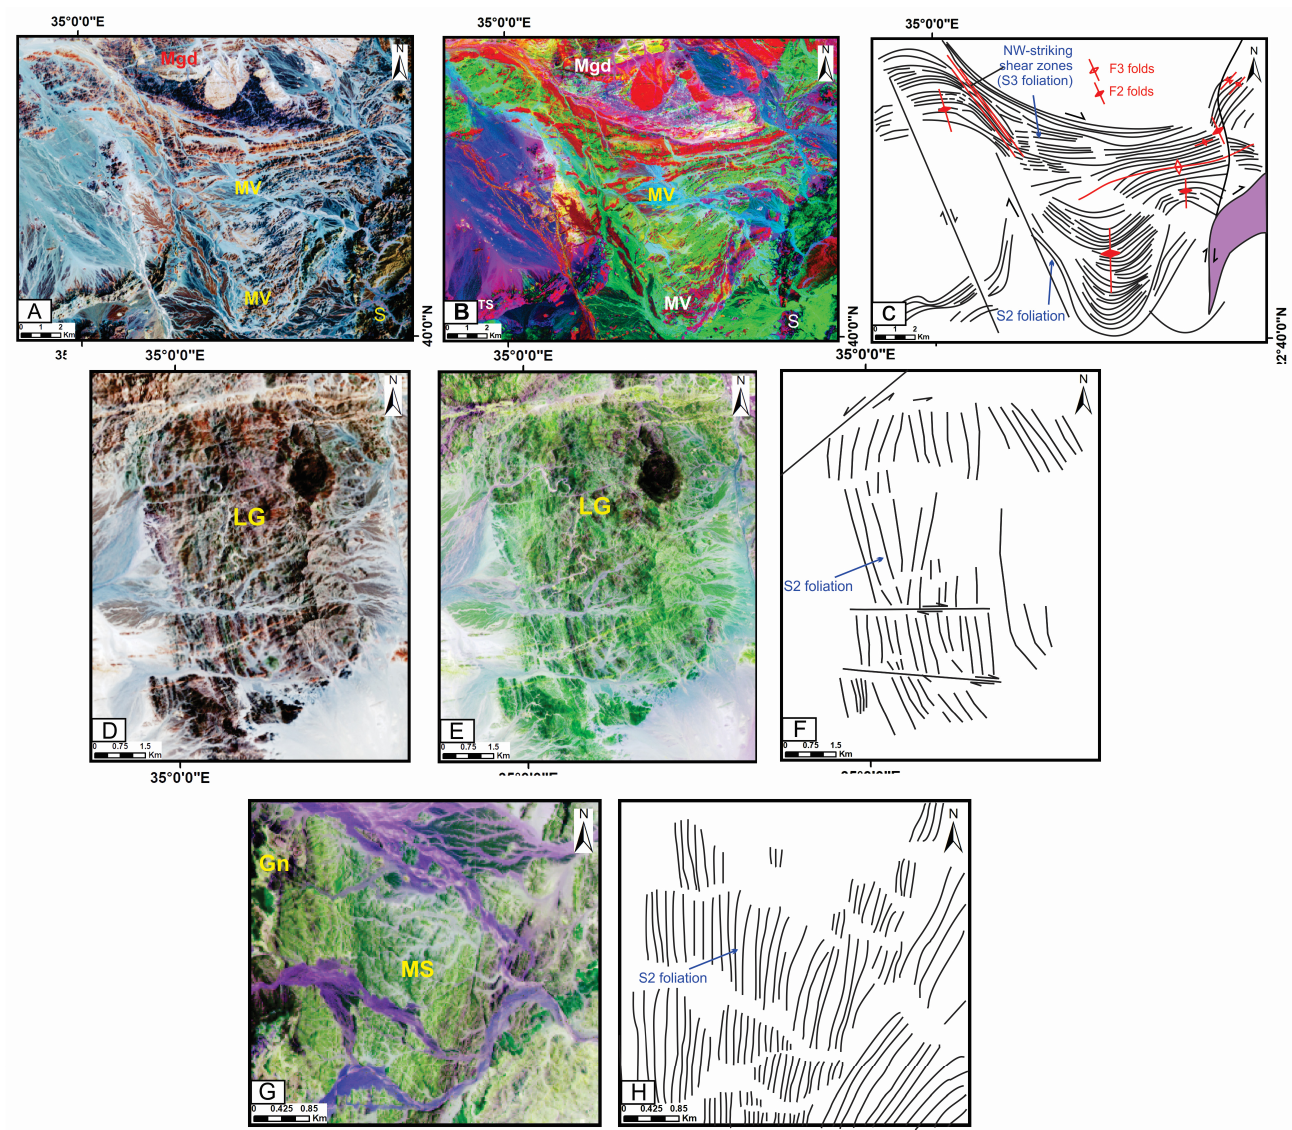
Figure 14. ( A , D ) Landsat-8 OLI band composites RGB-753, ( B , E , G ) Landsat-8 OLI band ratio RGB- 7/6, 6/5, 4/2 highlighted the different folding types and trends, and ( C , F , H ) the resultant interpreta- tion maps of the different fold generations (thin lines for foliation trajectories and red arrows lines are interpreted fold axial traces and major faults (black lines). Gn; gneisses, MS; metasediment, S; serpentinites, MV; metavolcanics, Mgd, sheared granodiorite, LG, layered gabbro. The northeastern and southwesterly boundaries of the Gerf nappe complex are marked by a conjugate set of sinistral strike-slip shear zones. The movement along these shear zone developed the moderately to steeply dipping mylonitic foliation (S3) that shows a sigmoidal trend inside the strike-slip shear zones and folded into small-scale folds in more constrained and distinct high-strain zones. With the progress of transpressional deformation along sinistral strike-slip shear zones, S2 deflected and rotated from NNW-SSE to ENE-WSW (S3) especially to the north of the Gerf nappe complex (Figure 12A). In mylonite schists, quartz ribbons, feldspar porphyroclasts, and amphibole needles identify down-dip mineral lineation that falls moderately to steeply along planes of intense mylonitic foliation. The L3 mineral lineation that plunges shallowly southwest is only found in steeply dipping strike-slip shear zones.